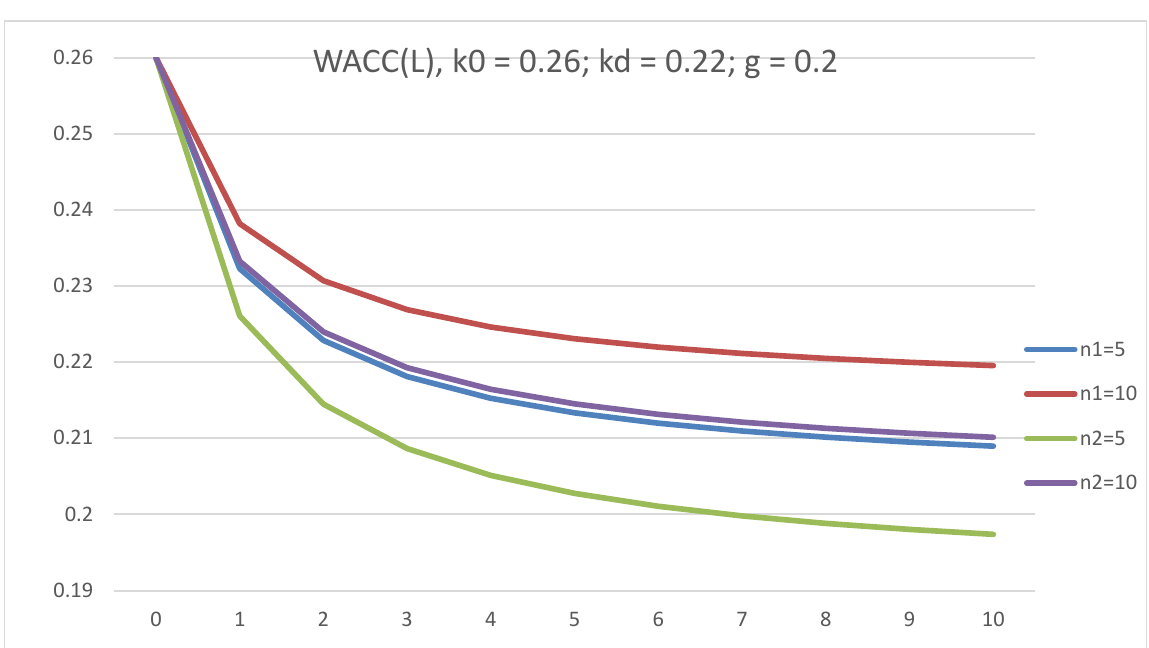
Figure 8. The dependence of equity cost, ke, on leverage level L in GBFO theory with payments of tax on profit at the end of periods (1) and advance payments (2) at k 0 = 0.26; k d = 0.22; 0.2; 0.18 t = 0.2; g = 0.05, for a five year company.